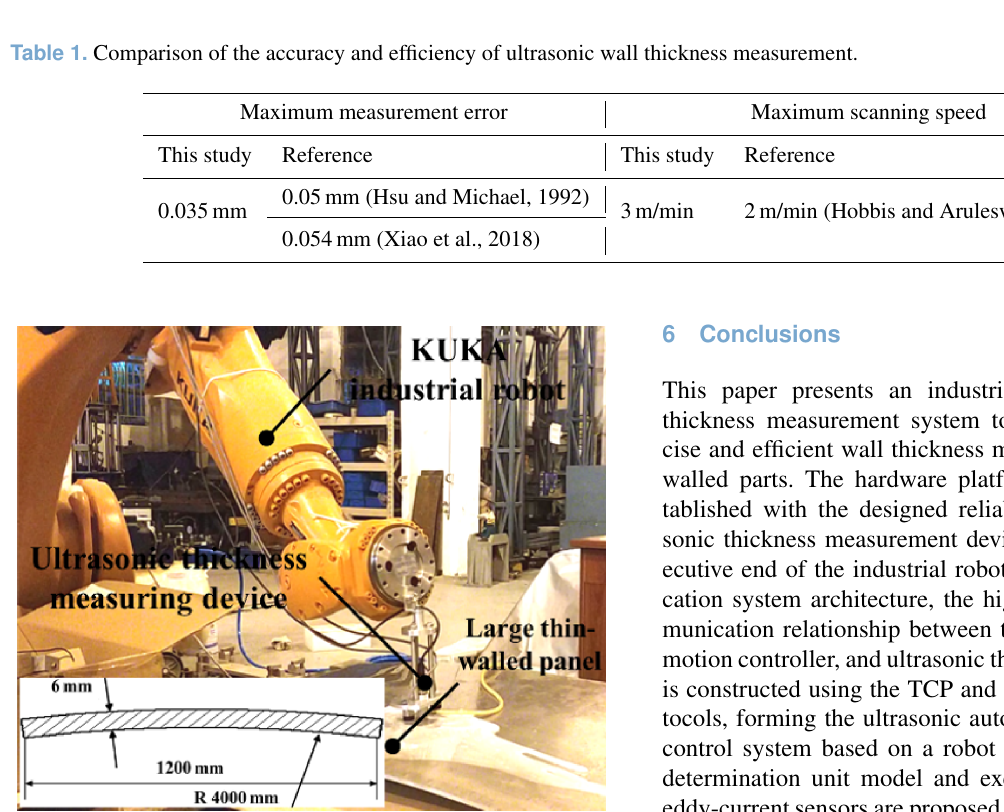
Figure 7. Robot-aided ultrasonic contactless scanning thickness measurement.